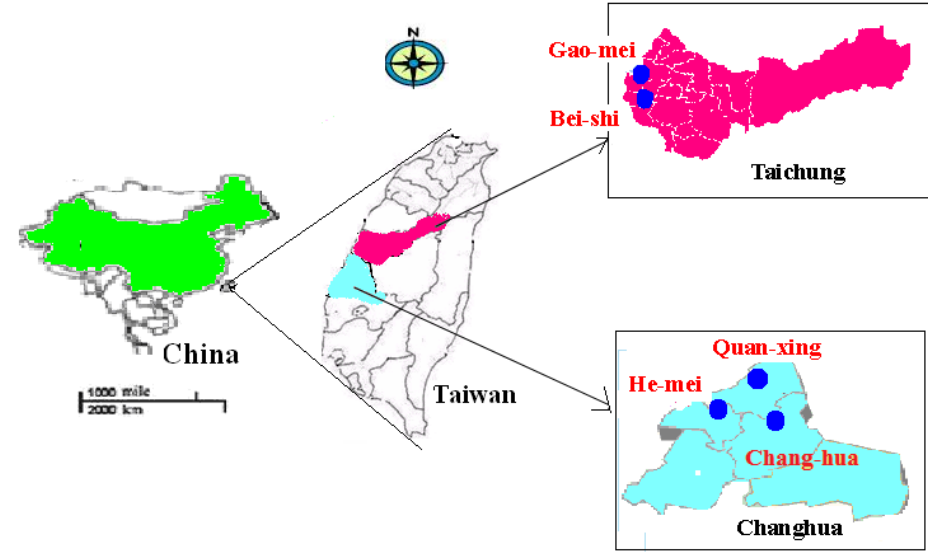
Fig. 1. Geographical location of the five sampling sites in central